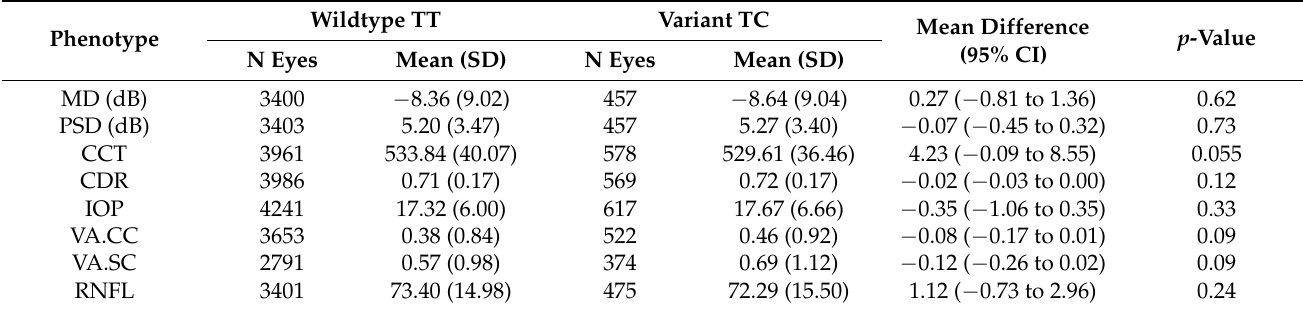
Table 1. Association of TRIM66 rs112369934 in quantitative phenotypes.